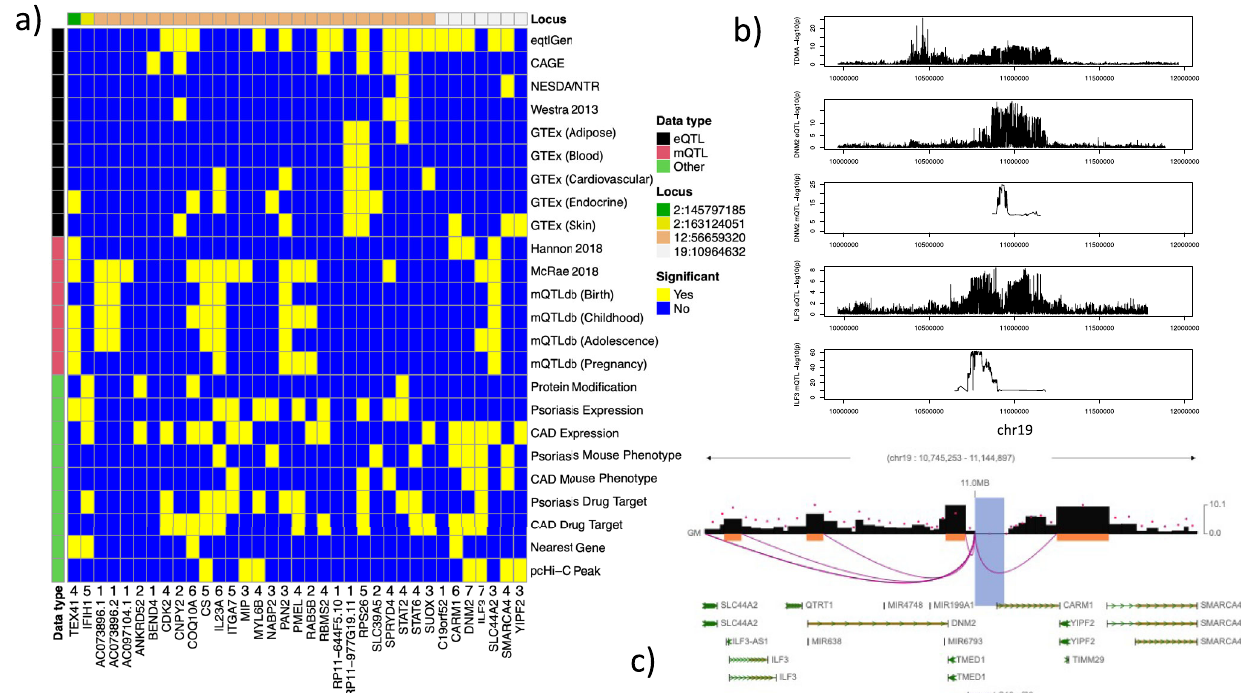
Fig. 3 | Gene prioritization. a Matrix of candidate genes by supporting evidence. Genesareincludedascandidatesifoneofthemarkersinthe95%Bayesiancredible interval (BCI) set for each TDMA locus is a signi fi cant eQTL, mQTL or have a direct protein modi fi cation effect for that gene. Cells colored in yellow indicate genes with signi fi cant supporting evidence, whilecells colored in blue donot. Sources of supporting evidence are grouped into three categories: eQTL (black), mQTL (red), and other ( green ). The color bar at the top of the matrix indicates the locus each genebelongsto(orderedbygenomicposition),withthepositionoftheTMDAlead markerforeachlocusbeingindicatedinthelegend.Therowofnumbers,belowthe